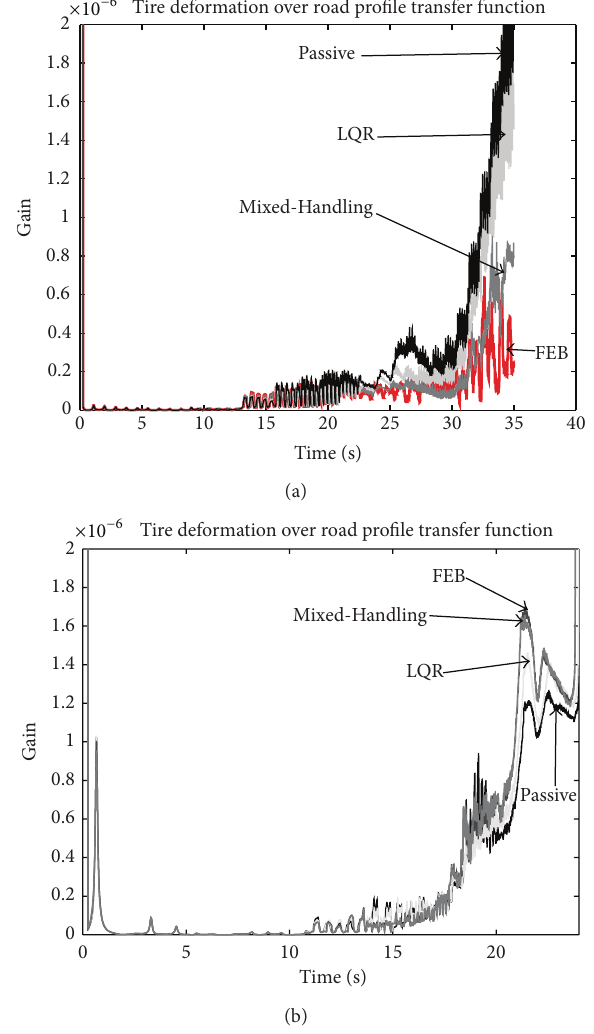
Figure 8: BOGGS test results: constant speed (top) and constant acceleration (bottom) tire deformation over the road.